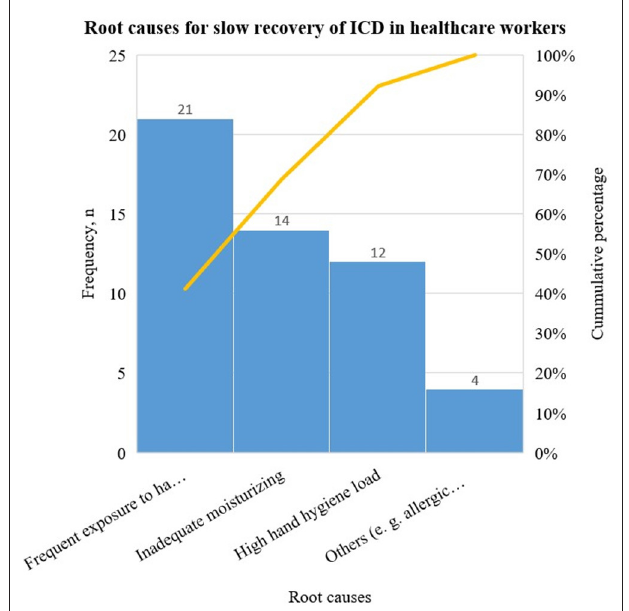
FIGURE 3 | Pareto chart of the different root causes. Root causes: frequent exposure to hand hygiene products, inadequate moisturising, high hand hygiene load and others (e.g., allergic contact dermatitis). High hygiene load denotes daily hand hygiene activities of fifty times and above.